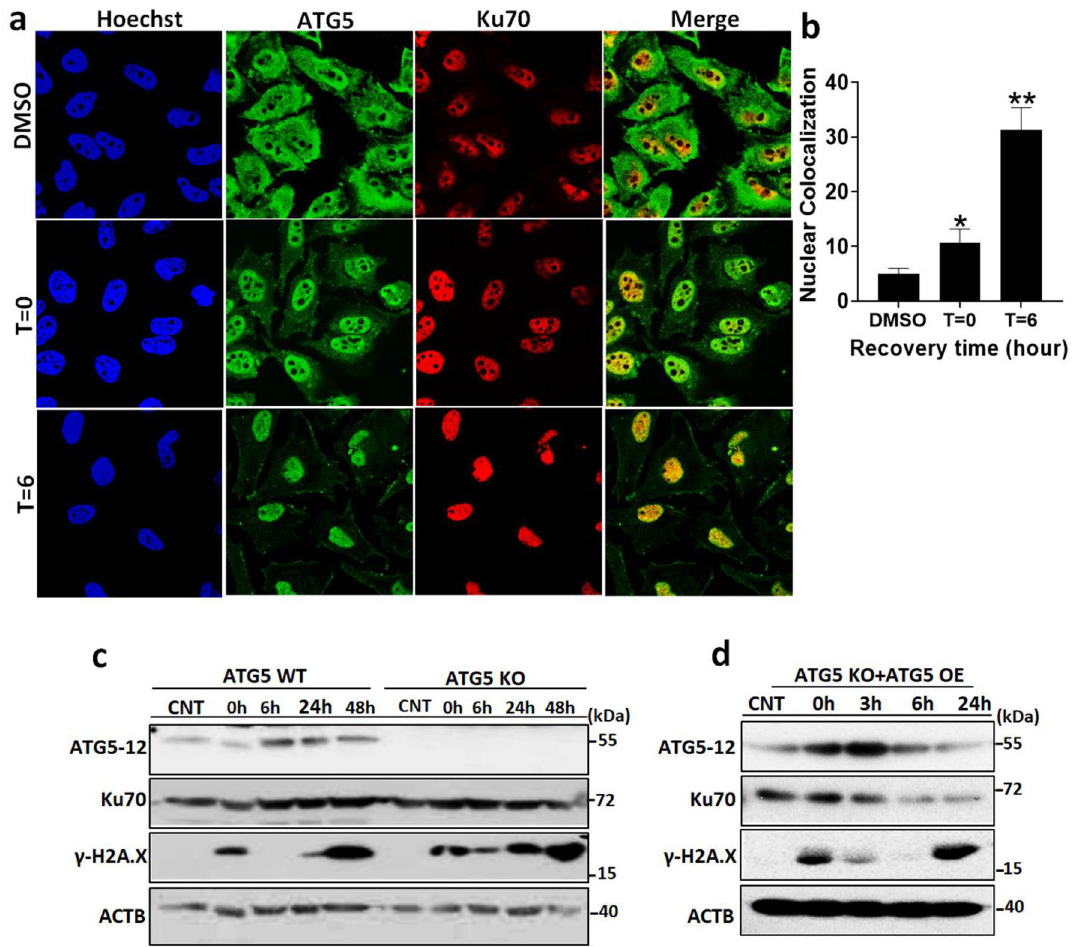
Figure 4. Role of ATG5-Ku70 interaction in DNA damage sensing and repair. ( a ) HeLa cells were cultured on coverslides and exposed to Etoposide for 1 h. DMSO was used as a vehicle. Etoposide was washed out after 1 h and cells were cultured for along 6 h to recover. t = 0, 1 h etoposide treated cells. t = 6, 6 h recovered cells. Cells were fixed and indirect immunofluorescent analysis was utilized. Alexa-488 (green) and Alexa-568 (red) were used as secondary antibodies against rabbit anti-ATG5 and mouse anti-Ku70, respectively. Cells were visualized under a confocal microscope at 63× magnification. Nuclei were stained with Hoechst (blue). Merge, overlay green and red signals. ( b ) Colocalization coefficients of 50 cells were calculated from confocal images and data represented as a graph (mean ± S.D. of independent experiments, n = 3, *, p < 0.05). ( c ) HeLa WT and ATG5 KO cells were treated with Etoposide for 1 h. After treatment etoposide was washed out and cells remained in the culture for along 6 h, 24 h and 48 h for recovery. CNT, DMSO treated cells as a vehicle. Then proteins were collected and analyzed by immunoblotting using anti-ATG5, anti-Ku70, and anti-γH2A.X. Anti-β-Actin was used as a loading control. ( d ) A rescue experiment was performed. HeLa ATG5 KO cells were cultured and transfected with ATG5 expressing plasmid. 48 h post-transfection cells were treated with etoposide for 1 h. After treatment etoposide was washed out and cells remained in the culture for along 6 h, 24 h and 48 h for recovery. CNT, DMSO treated cells as a vehicle. Then cells were collected and analyzed by immunoblotting using anti- ATG5, anti-Ku70, and anti-γH2A.X. Anti-β-Actin was used as a loading